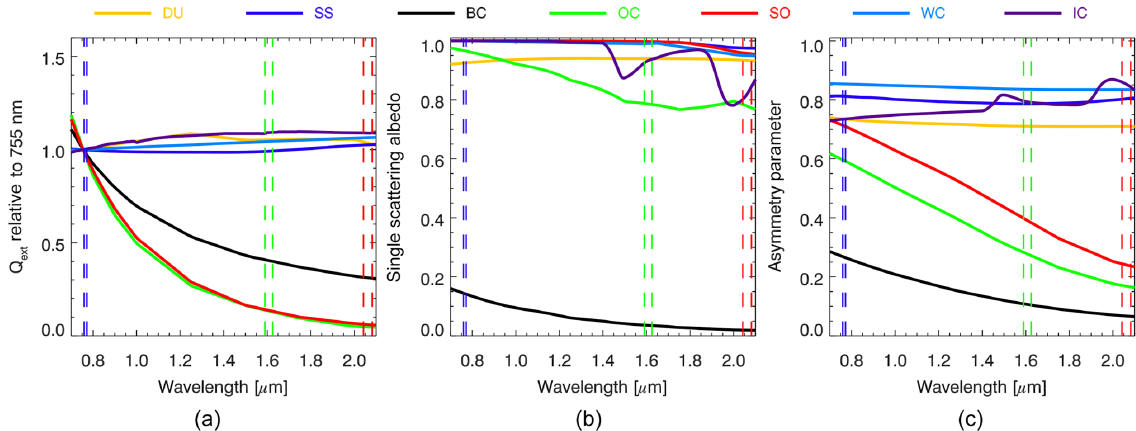
Figure 3. Optical properties of aerosols and clouds used in the L2FP code as a function of wavelength. (a) Extinction efficiency relative to that at 755nm. (b) Single scattering albedo. (c) Asymmetry parameter. DU: dust, SS: sea salt, BC: black carbon, OC: organic carbon, SO: sulfate, WC: water cloud, IC: ice cloud. The spectral ranges of the three OCO-2 bands are demarcated by the dashed vertical lines.